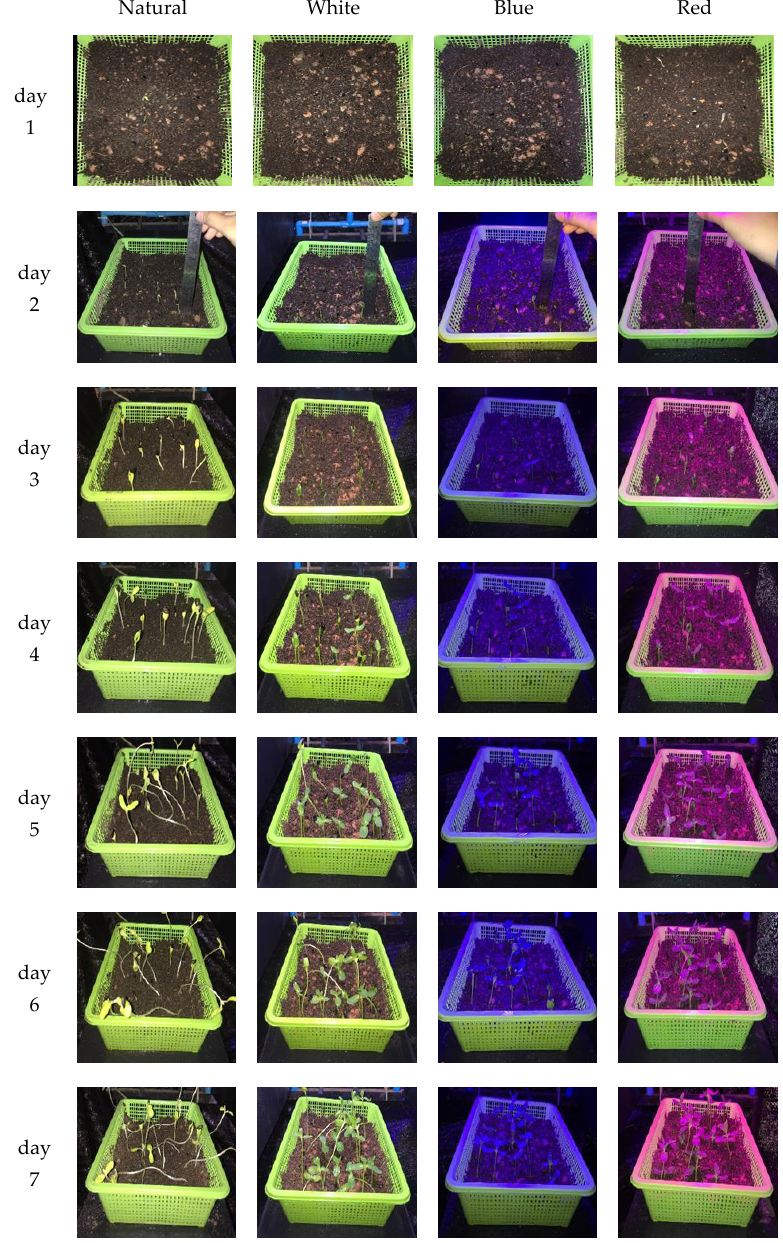
Figure 6. Sunflower seedlings treated under natural, white, red, and blue lights for 7 days. From the 4th day onwards, the numbers were unchanged. As a result, we calculated the germination indices; the results ranked from highest the lowest were 3.43 (red), 3.14 (white), 2.86 (natural), and 2.71 (blue). This indicates that red light provided the highest ability for germination of sunflower seeds, while blue light was the lowest. Our results are in line with the literature but for different plant species, i.e., Cucumis callosus seeds, Pinus virginiana Mill seeds, and M. aegyptia. Moreover, we observed that natural light had a germination success number close to that of white light. This may be because the natural light has a color similarly to white. The germination of seeds exposed to different light colors corresponding to the number of germination days can be expressed as an ex- ponential rise function as shown in Table 1.